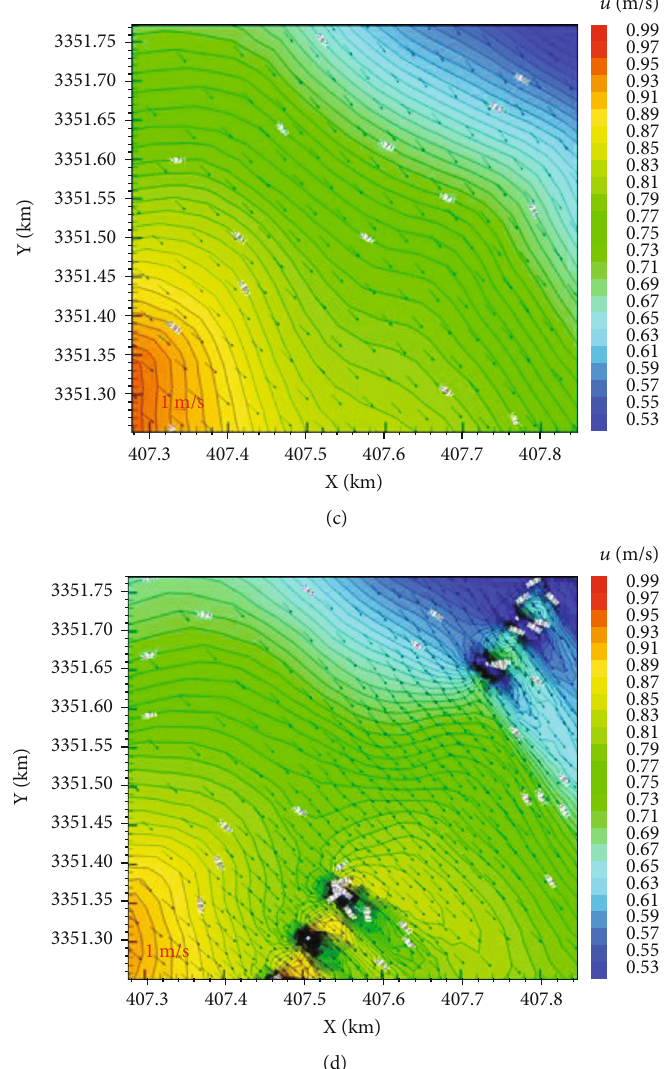
Figure 11: Comparison of fl ow fi eld distribution before and after the construction of the project (direction of the ebb tide is positive, and u indicates the fl ow velocity). (a, b) Rapid rise of neap tide. (c, d) Rapid fall of neap